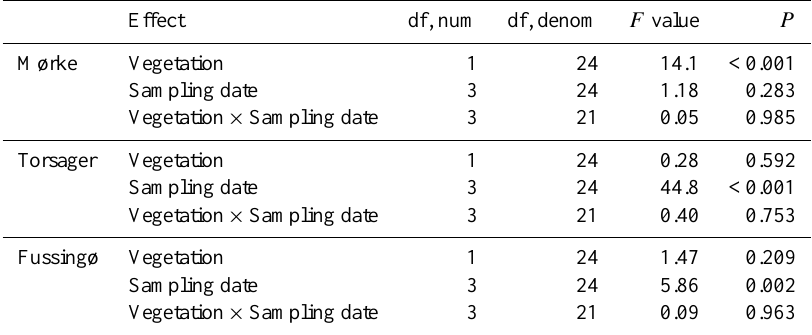
Table 4. Effects of vegetation (with or without Juncus effusus ) and sampling date on methane (CH 4 ) emission rates were evaluated using a linear mixed model for each of the three sites separately.